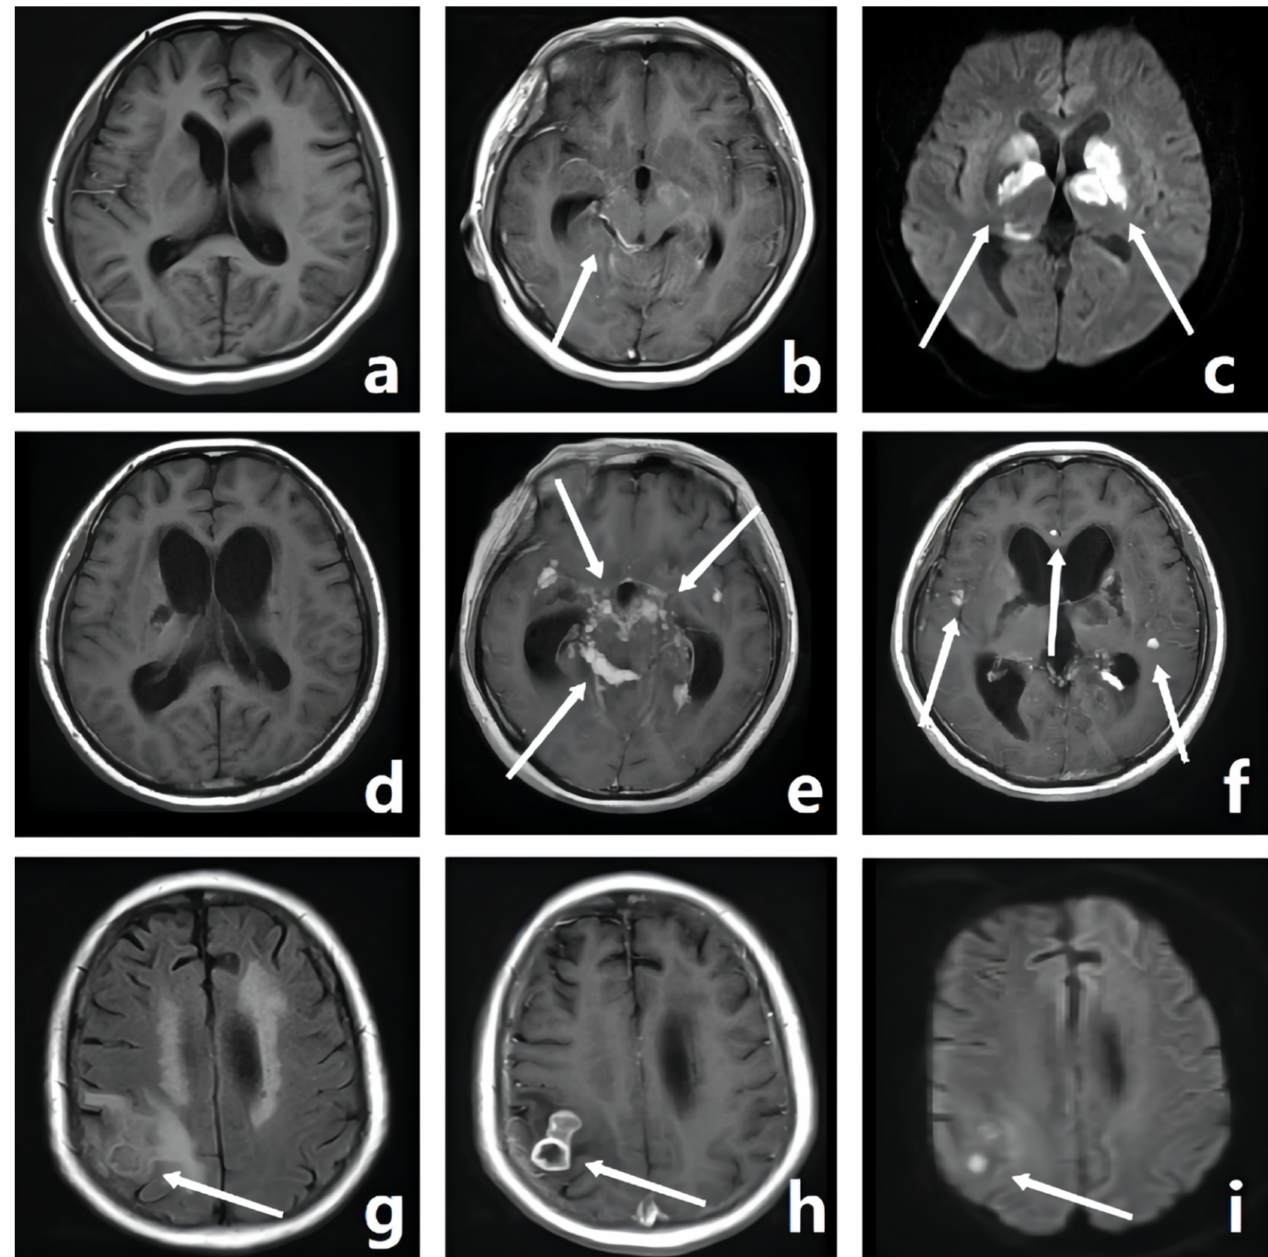
Figure 1. A 26-year-old female. There was exudation in her skull base, and the meninges of the ambient cistern and lateral fissure cistern were enhanced on T1WI (( b ), white arrow). She had ACI in the bilateral basal ganglia, which showed hyperintensity on DWI (( c ), white arrows). One month later, the patient was reexamined with MRI. She developed moderate hydrocephalus with an Evan’s ratio of 0.35 ( d ), compared with the initial Evan’s ratio of 0.30 ( a ). There are countless tuberculomas in the meninges (( e ), white arrows) and brain parenchyma (( f ), white arrows), showing obvious homogeneous nodular enhancement. Another 70-year-old female. She had several brain abscesses in the right parietal lobe and multiple OCIs in the radiated coronal area (( g ), white arrow). The abscess wall showed ring-shaped enhancement (( h ), white arrow), and the abscess cavity showed obvious high signal intensity on DWI (( i ), white